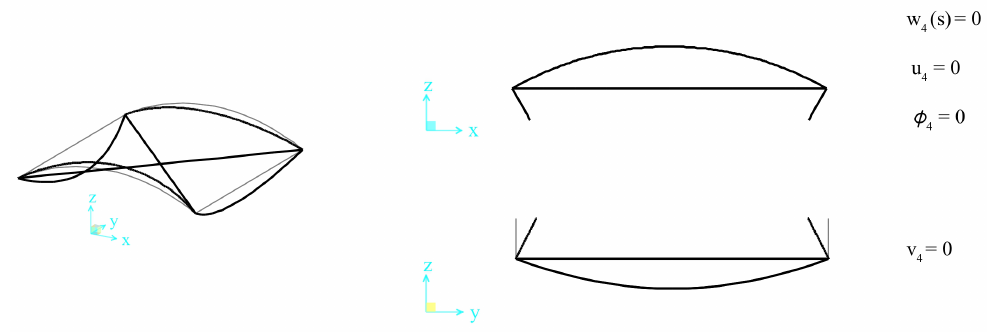
Figure 10. Deformed configuration of the problem